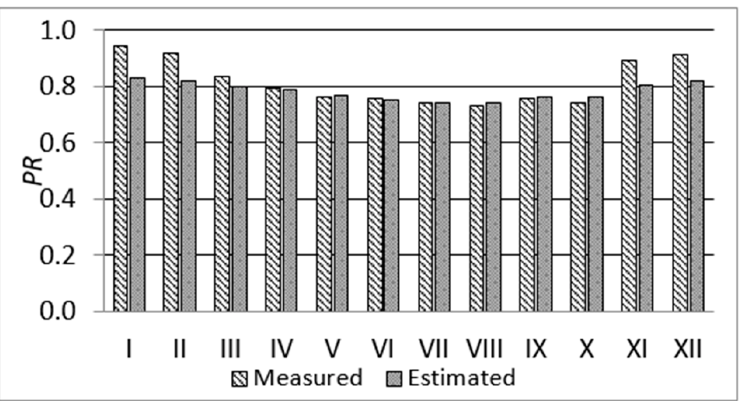
Figure 5. Change of the estimated and measured PR by months.